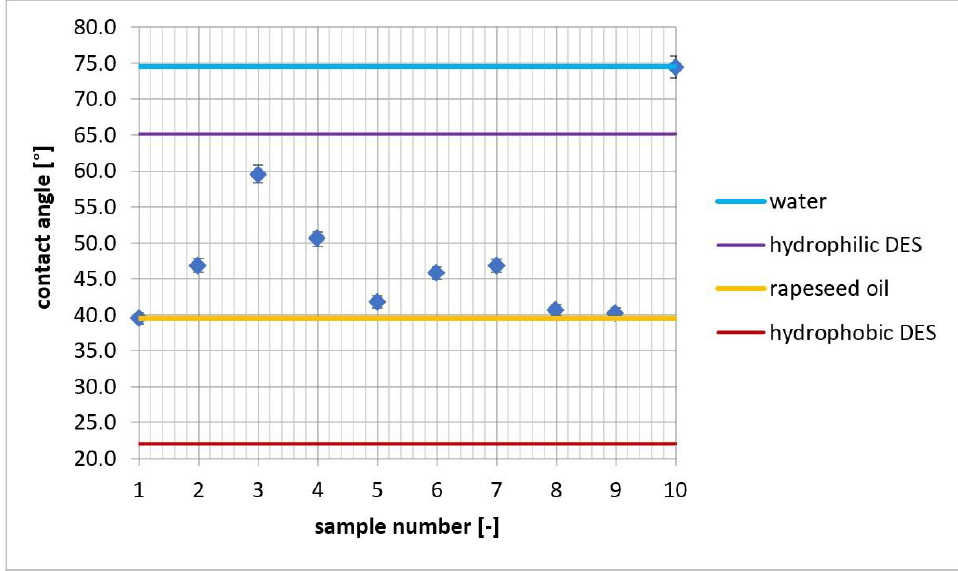
Figure 1. Contact angle: 1 — rapeseed oil, 2 – 9 — DESs, and 10 — water — on glass.